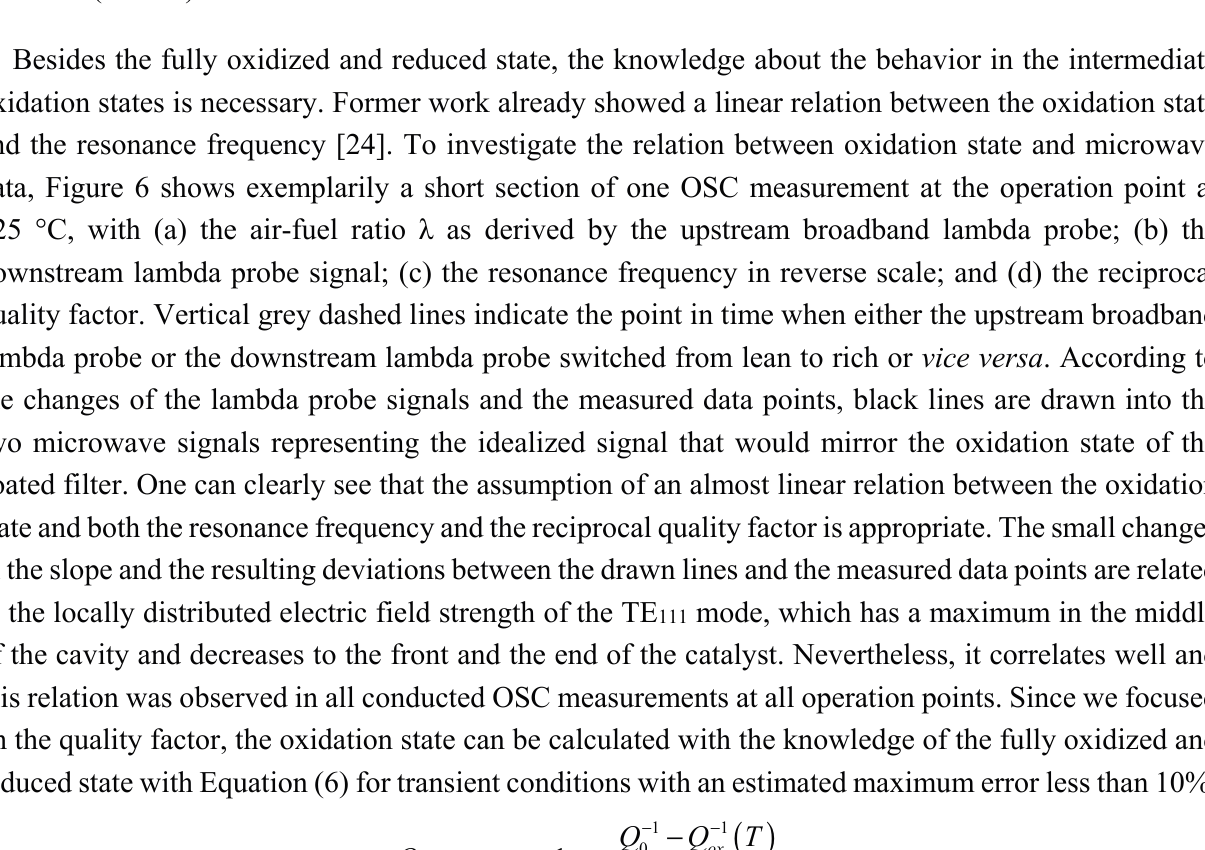
Figure 5. Comparison of the characteristic curves of Q 0 − 1 in an Arrhenius-like representation: the oxidized (black) and reduced (grey) state for the samples C1 (solid) and C2 (dashed) with doubled Ceria